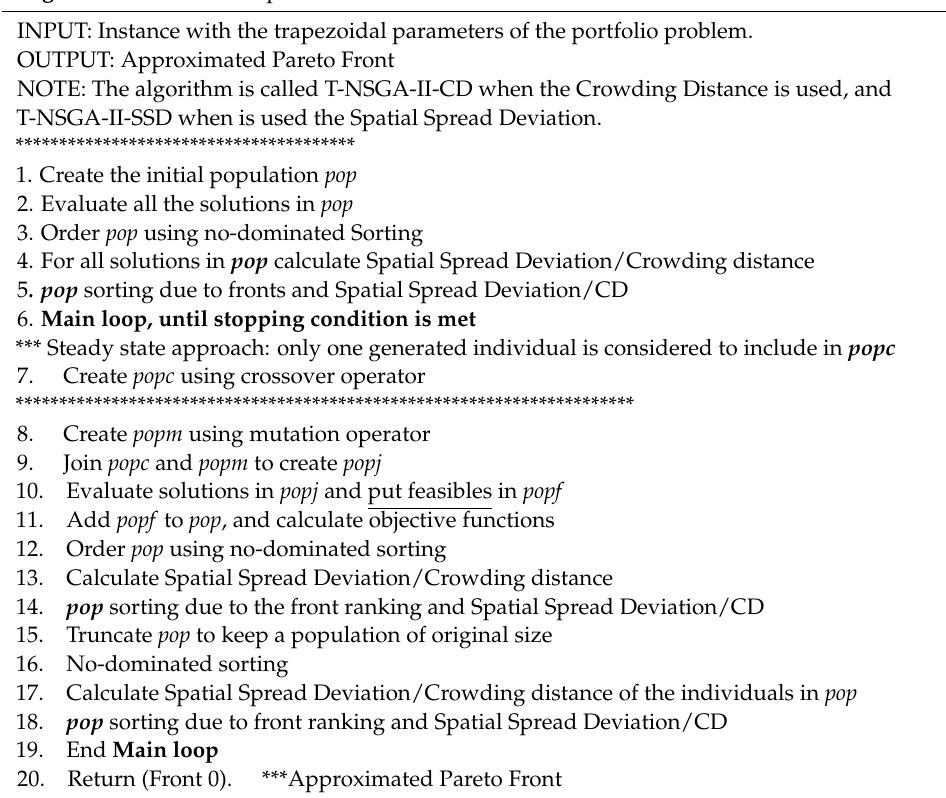
Algorithm 3. T-NSGA-II